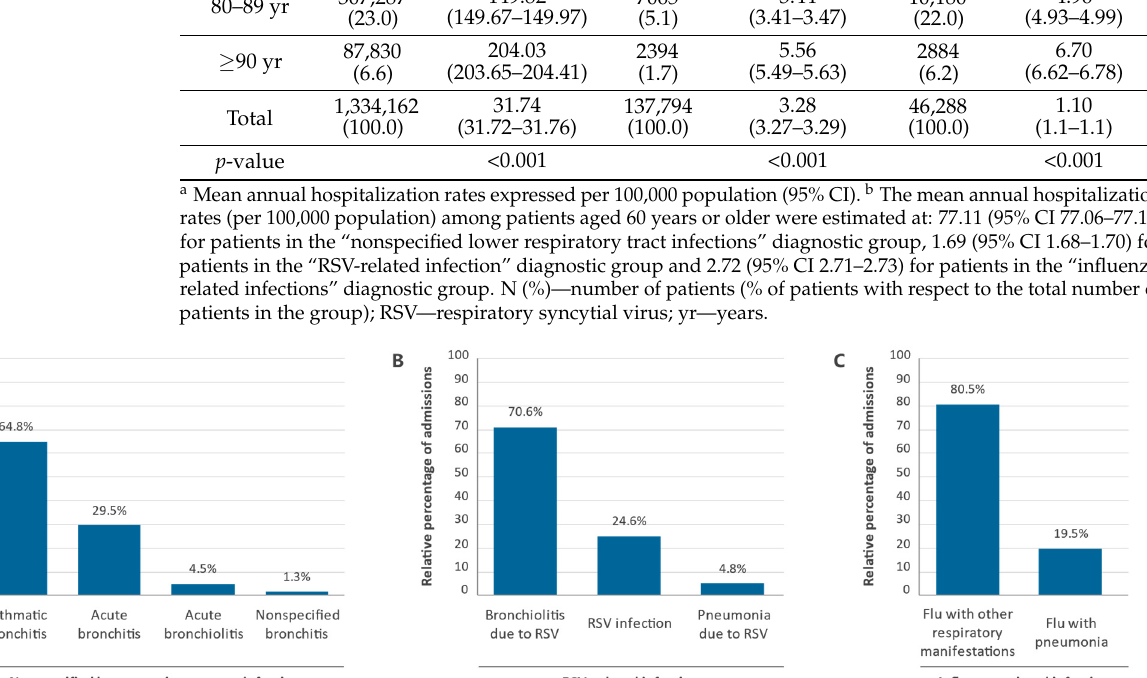
Figure 1. Relative percentages of admissions for the different diagnostic codes of diseases of the respiratory system in Spain between 2012 and 2020 by diagnostic group. ( A ) Nonspecified lower respiratory tract infection, ( B ) RSV-related infection, and ( C ) Influenza-related infection. Almost 60% of patients in this group of diagnostic codes were 60 years of age or older ( n = 791,740; 59.3%), and their hospitalization rate was more than twice the overall rate for all ages in this group, 77.11 (95% CI 77.06–77.16) per 100,000 population (Table 3). The